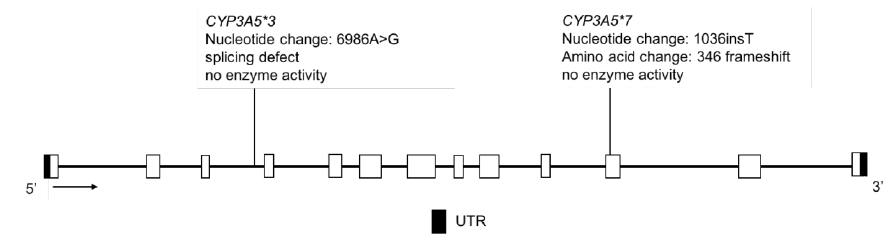
Figure 12. The human CYP3A5 gene and the variants tested for in the CSKT population. Not shown is CYP3A5*6 , where alternative splicing results in exon 7 skipping. Open boxes represent exons, lines represent introns and shaded boxes represent UTR. Table 11. Comparison of CYP3A4 allele frequencies Indigenous North American populations to global populations from the 1000 Genomes Project [20]. N represents the number of alleles. Not shown are CYP3A4*2 (rs55785340), CYP3A4*4 (rs55951658) and CYP3A4*8 (72552799), as these variants were either not detected or not tested for in the Indigenous populations studied. Global populations are abbreviated as follows: African Ancestry in Southwest US (ASW); Utah residents with Northern and Western European ancestry (CEU); Han Chinese in Beijing, China (CHB); Mexican Ancestry in Los Angeles, California (MXL). Country [20] Table 12. Comparison of CYP3A5 allele frequencies Indigenous North American populations to global populations from the 1000 Genomes Project [20]. N represents the number of alleles. Global populations are abbreviated as follows: African Ancestry in Southwest US (ASW); Utah residents with Northern and Western European ancestry (CEU); Han Chinese in Beijing, China (CHB); Mexican Ancestry in Los Angeles, California (MXL). Country